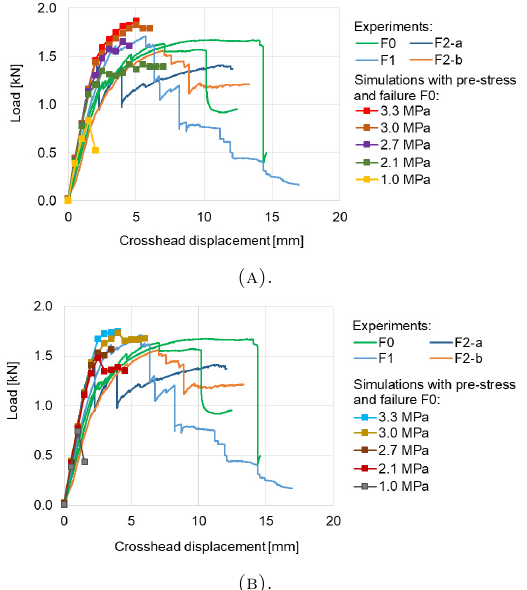
Figure 18. Load vs. crosshead displacement for the results of CT test experiments and simulations calculated for different pre-stress levels with (A) θ c = 0 . 4° and (B) θ c = 1 . 4° leading to failure type F0.